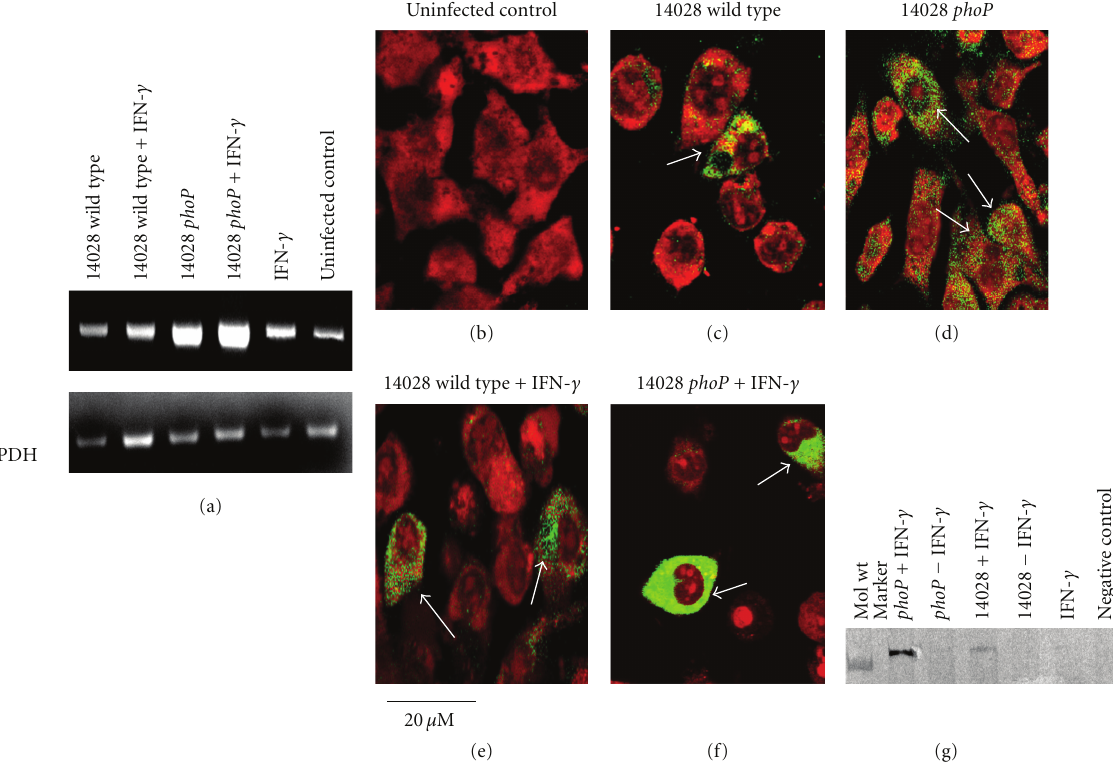
Figure 2: S. typhimurium 14028 phoP regulon suppresses iNOS mRNA and protein expression in murine macrophages but fails to suppress iNOS when co-cultured with IFN- γ . (a) PCR showing iNOS mRNA expression is reduced in macrophages cultured with 14028 wild type compared to 14028 phoP mutants. The addition of IFN- γ to culture media increased iNOS mRNA expression in macrophages infected with either wild type or phoP mutant. (b) Intracellular iNOS protein cannot be detected by immunocytochemistry in uninfected (control) macrophages. (c) Suppression of intra-cellular iNOS protein observed in macrophages cultured with wild type 14028 compared to macrophages cultured with phoP mutants (d). Addition of IFN- γ to cell culture media also increased intra-cellular iNOS in macrophages cultured with wild type 14028 (e) or phoP mutants (f). Arrows show iNOS positive cells, scale bar bottom left: 20 μ m. (g) Western blot of iNos protein in whole cell preparations stimulated with wild type 14028 or 14028 phoP with or without IFN- γ . Lane 1, molecular weight marker: 130 kDa. Lane 7: Unstimulated J774 cells (negative control). All analyses are representative of data obtained on 3 separate